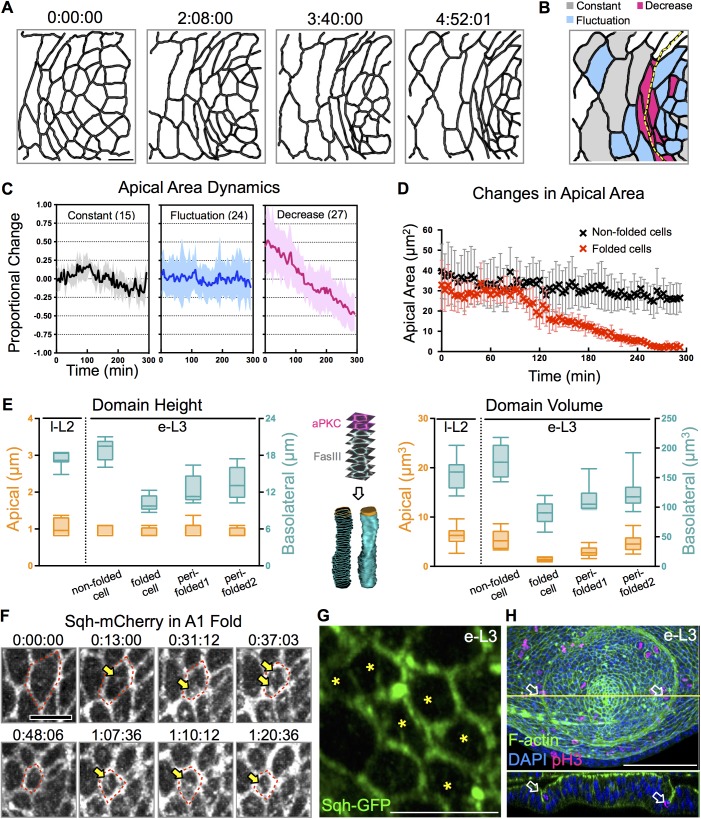
Apical constriction and cell shape changes during A1 fold formation.(A) Time-lapse images of Sqh-GFP in ex vivo cultured l-L2 EAD for 5 hours. Imaris filament, and surface-tracing modules were used for individual cell segmentation and tracing. (B) Cells are classified into three groups based on their dynamic changes in the apical area and are shown for Tfinal (4:52:01). Cells that showed a significant reduction in apical size (from 30–40μm2 to <10μm2) are labeled red. Cells that showed a fluctuating apical area, defined as δAreai (Amaxi-Amini) ≥ 10μm2 over time, are labeled blue. Otherwise, cells were considered to have a constant apical area (labeled grey). The yellow dashed line marks the A1 fold at Tfinal. (C) Cells in each group are plotted according to by their proportional change in apical area ((Ati−Aavgi) /Aavgi) over time. Mean ± stdev are shown as a solid line and lightly shaded area, respectively. The ranges of stdev for the constant and the fluctuating groups are 0.05–0.4, and 0.3–0.9, respectively. Analyzed cells in each group are indicated. (D) The apical areas of cells located at the A1 fold were significantly reduced 2h prior to fold formation (at 180min). Mean ± stdev are shown. Cells away from the fold do not show a significant reduction in apical area. (E) Quantitation of cell height and volume from l-L2 and e-L3 EAD. Stack contours from aPKC (apical, magenta) and FasIII (basolateral, white) staining for volume rendering are illustrated in the middle panel. In addition to cells at the A1 fold, cells one row (perifold-1) and two rows (perifold-2) away from the A1 fold were also scored. (F) Sqh-mCherry accumulates periodically in the apical-medial region (yellow arrow) of constricting cells (red dashed line). Original time-lapse images: see S1 Movie. (G) During e-L3, the cells at the fold (marked by stars) exhibit an even distribution of Sqh-GFP (green) in a 2–3μm stack image projection (N = 4). (H) Mitotic cells (pH3, magenta) are observed along the A1 fold (arrow) during e-L3 (DAPI, blue; F-actin, green). EAD presented 3–4 mitotic cells (N = 7). Scale bars: 5μm, except in H for which it is 50μm. Time indicated as hh:mm:ss.